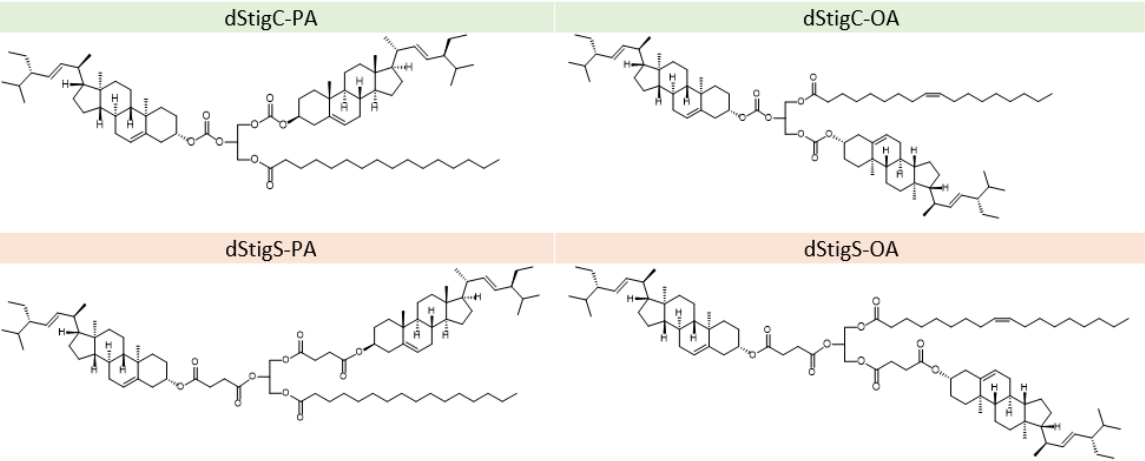
Figure 1. Structures of the studied compounds (dStigMAs): 1,2-distigmasterylcarbonoyl-3-palmitoyl- sn -glycerol (dStigC-PA); 2,3-distigmasterylcarbonoyl-1-oleoyl- sn -glycerol (dStigC-OA); 1,2-distigmasterylsuccinoyl-3-palmitoyl- sn -glycerol (dStigS-PA); 2,3-distigmasterylsuccinoyl-1-oleoyl- sn -glycerol (dStigS-OA). The fluorescent probe 1,6-diphenyl-1,3,5-hexatriene (DPH) was purchased from Molecular Probes